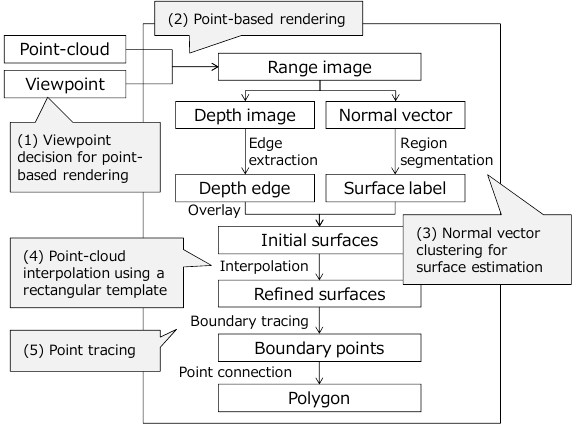
Figure 2. The five components of processing flow 2.1 Viewpoint decision for point-based rendering